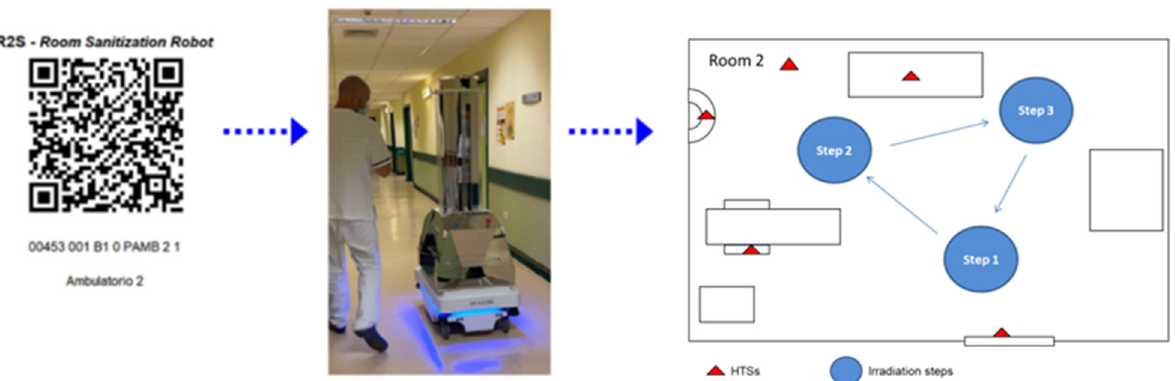
Figure 1. Workflow of the R2S system. R2S robot is equipped with a dedicated app able to read a QR code in which the mission is memorized (all the steps and the time of irradiation of each stop point).